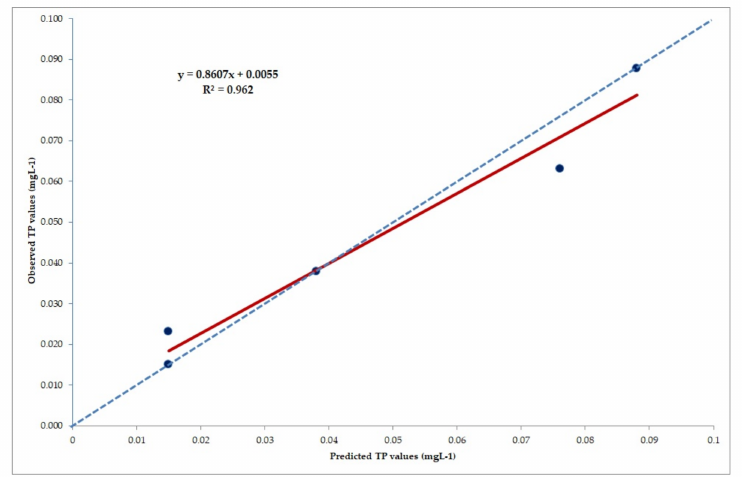
Figure 3. Determination coefficient between observed and predicted TP values by